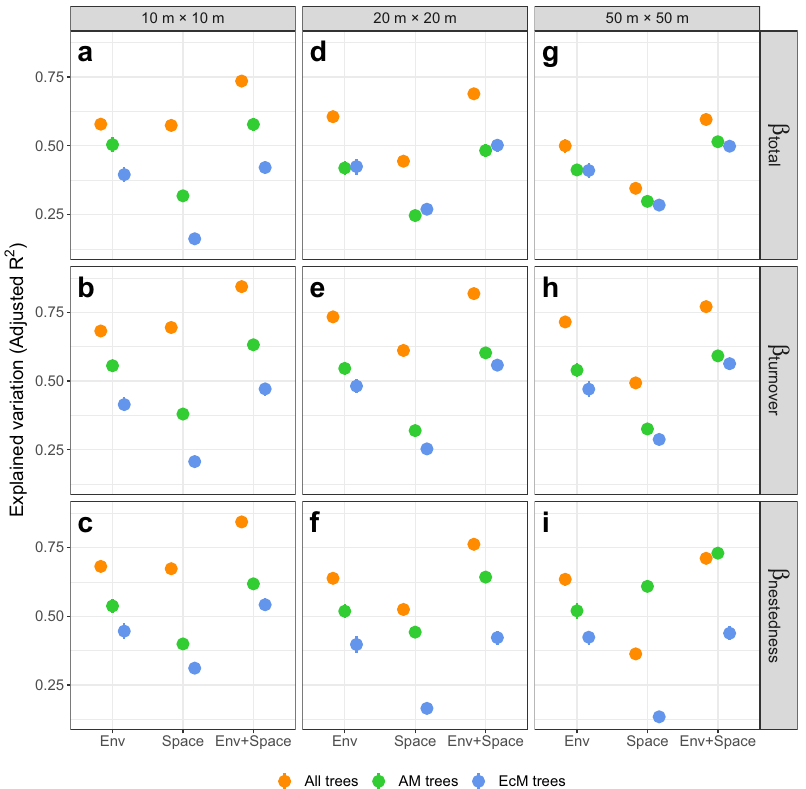
Fig. 3 Variation partitioning of tree beta-diversity. Variation of total beta-diversity, species turnover, and species nestedness of all trees, AM trees, and EcM trees at quadrats scales of 10 m × 10 m ( a – c ), 20 m × 20 m ( d – f ), and 50 m × 50 m ( g – i ) explained by spatial and environmental variables. Orange, green, and blue points represent total beta-diversity and its two components (species turnover & nestedness) of all trees, AM trees, and EcM trees. “ Env ” , “ Space ” , and “ Env + Space ” represent the effects of environmental variables, spatial variables, and both, respectively. Average total beta-diversity and its two components were calculated based on 30, 15, and 15 randomly sampled quadrats of 10 m × 10 m, 20 m × 20 m, and 50 m × 50 m from each forest plot, respectively. The calculation and variation partitioning of total beta-diversity and its components were repeated 200 times. Means and 95% con fi dence intervals (95% CIs) of explained variation of total beta-diversity and its components were estimated using the non-parametric bootstrapping ( n = 200 replicates). The means were showed as points and 95% CIs were showed as error bars. Differences between the variation explained by spatial and environmental variables were tested for signi fi cance using two-sided Mann – Whitney U tests: n.s. P ≥ 0.05, * P < 0.05, ** P < 0.01, *** P < 0.001. W = 19225 and P = 0.5029 for species turnover, W = 21765 and P = 0.127 for species nestedness, and W = 20557 and P = 0.6303 for total beta-diversity at the scale of 10 m × 10 m, and P < 0.0001 for